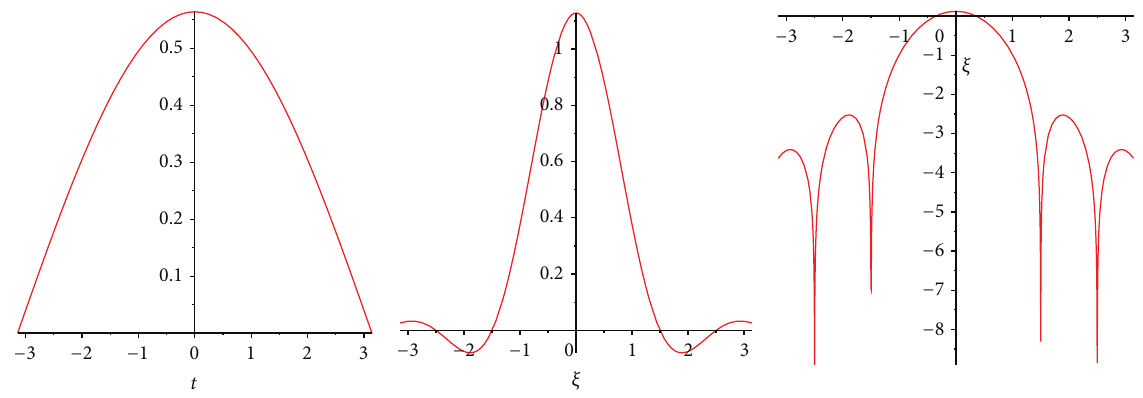
Figure 1: The figure shows window function 𝑔(𝑡) = √1/𝜋 cos (𝑡/2) 1 [−𝜋,𝜋] (𝑡) , its Fourier transform ̂𝑔 , and log (|̂𝑔|) .